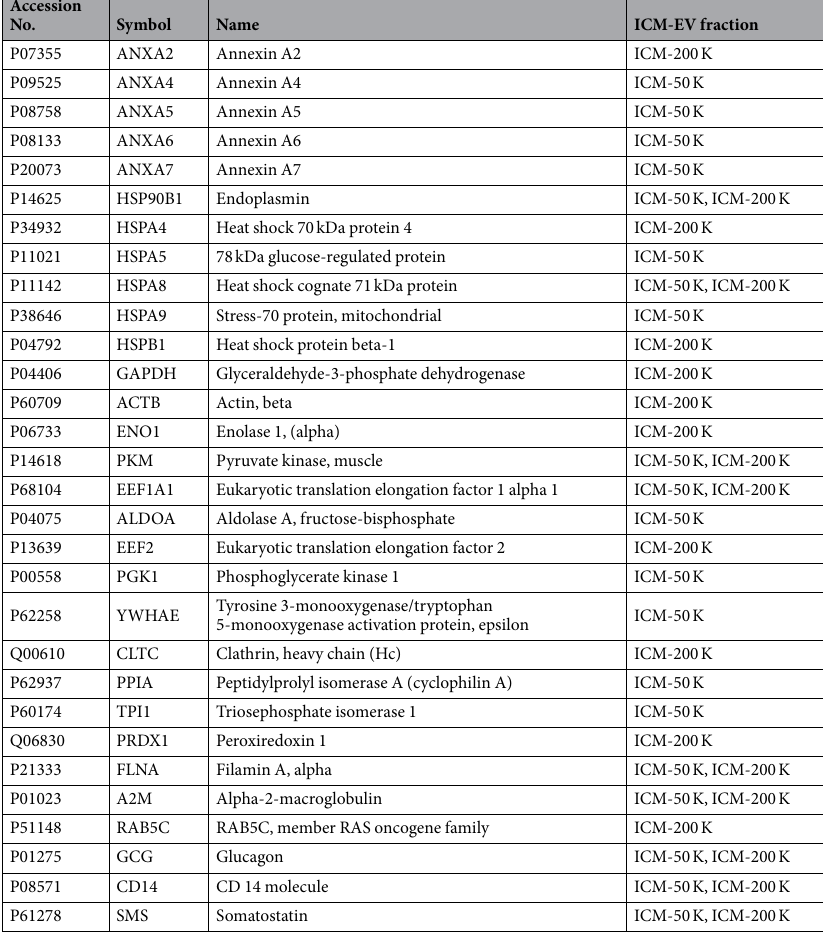
Table 1. List of proteins commonly associated with extracellular vesicles and islet cells identified by LC-MS/MS within fractionated human